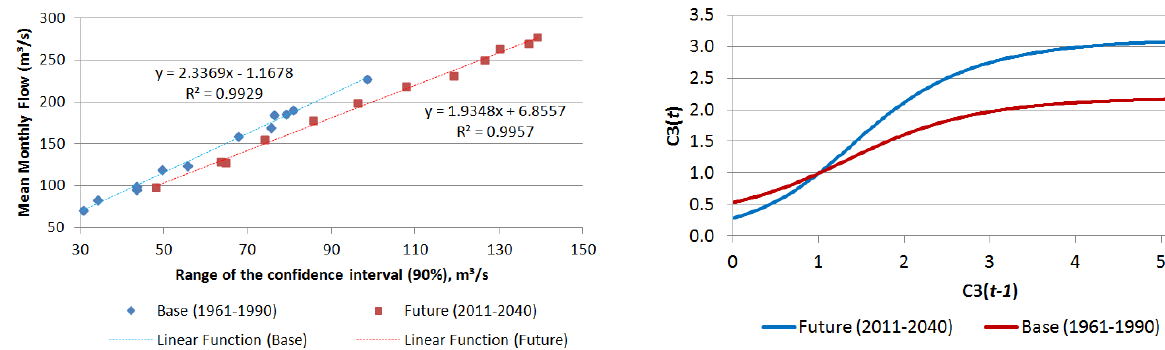
Figure 12. Relationship between the mean of the monthly flow and the range of the confidence interval for the periods between 1961 and 1990 (base) and between 2011 and 2040 (future).